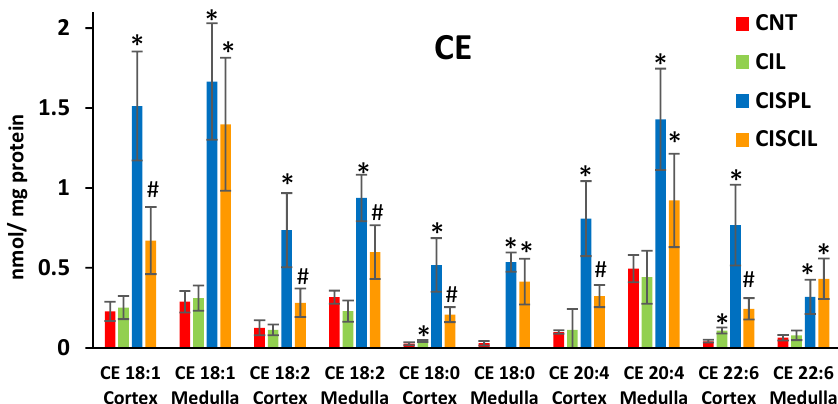
Figure 3. Cholesterol ester (CE) species found in the renal cortex and medulla in CNT, CIL, CISPL, and CISCIL groups. * p < 0.05 vs. CNT. # p < 0.05 vs. CNT and CISPL. FDR < 0.1 was considered. Data are presented as the mean ± sd; n = 6 animals per group.